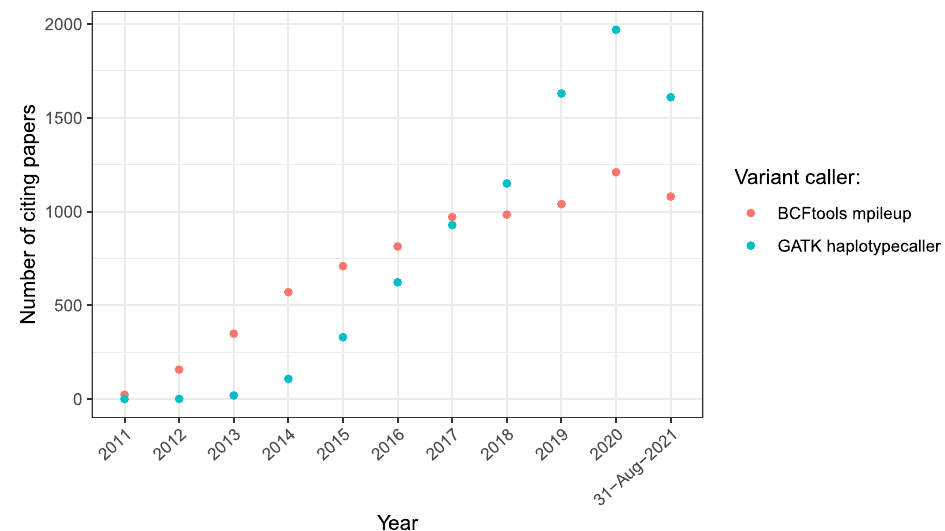
Figure 1. The number of papers citing ’mpileup’ or ’HaplotypeCaller’ (source: Google Scholar).